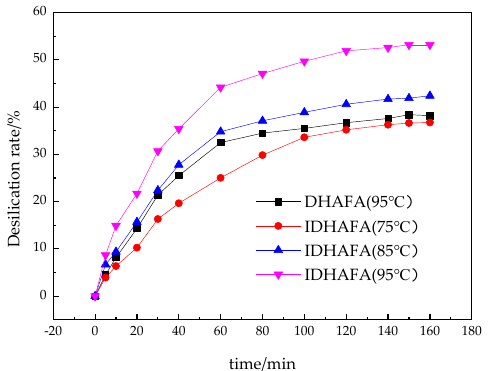
Figure 6. Effect of reaction time and temperature on the desilication rate of IDHAFA and DHAFA (Predesilication conditions: C (Na 2 O) = 140 g/L, and L/S = 3.5).